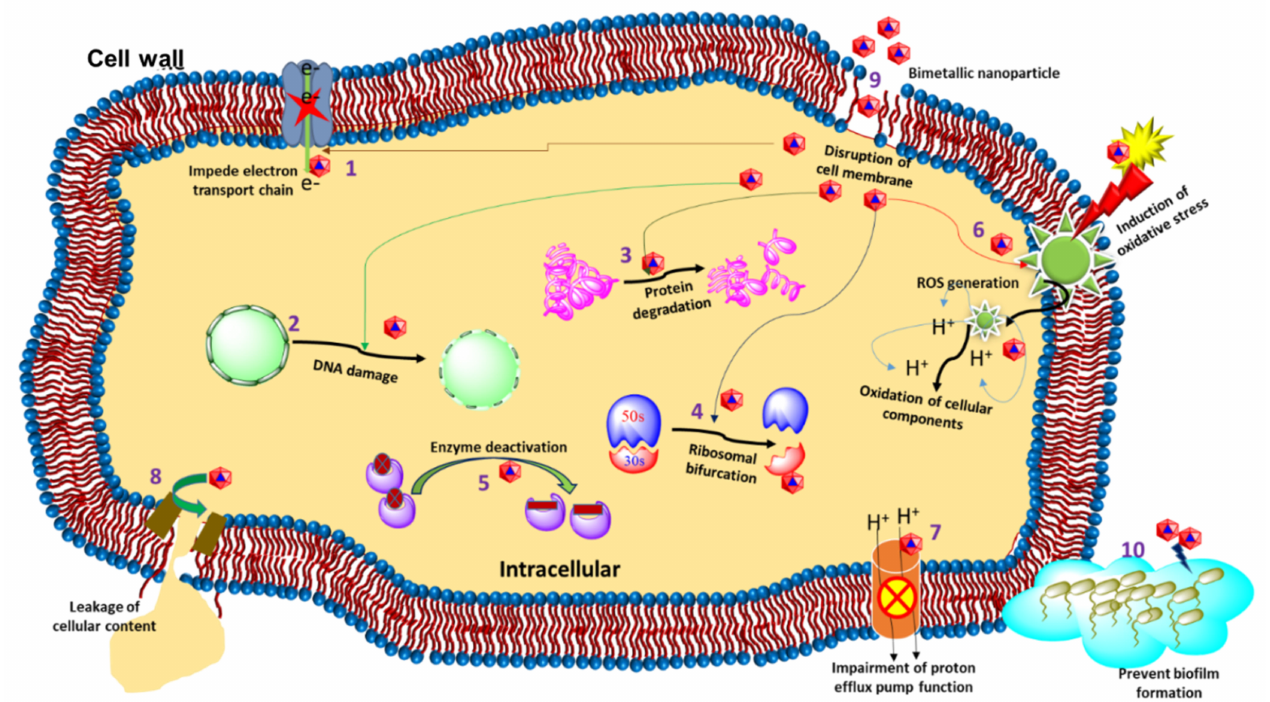
Figure 2. Different antibacterial modes of action displayed by bimetallic Au–Ag NPs. (1) Impede electron transport chain, (2) DNA damage, (3) Protein degradation, (4) Ribosomal bifurcation, (5) En- zyme deactivation, (6) Reduces ROS generation, (7) Impairment of proton efflux pump function, (8) Leakage of cellular content (bacteria), (9) Disruption of the cell membrane and (10) Prevention of biofilm